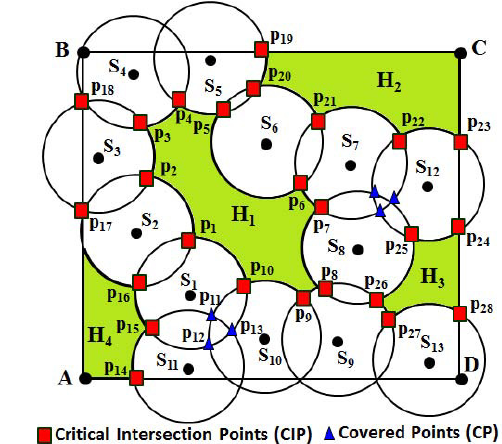
Figure 2. Example of coverage holes, critical intersection point (CIP) and covered point (CP). De f